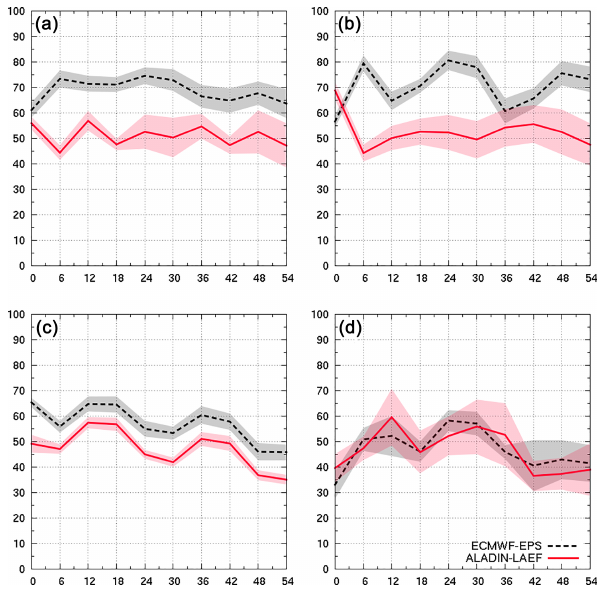
Figure 8. Outliers of 2m temperature (a) , relative humidity (b) , 10m wind (c) and mean sea level pressure (d) versus forecast lead time, calculated against SYNOP observations for ECMWF ENS downscaling (black) and new ALADIN-LAEF Phase I (red). Shad- ing denotes 10% and 90% confidence intervals.